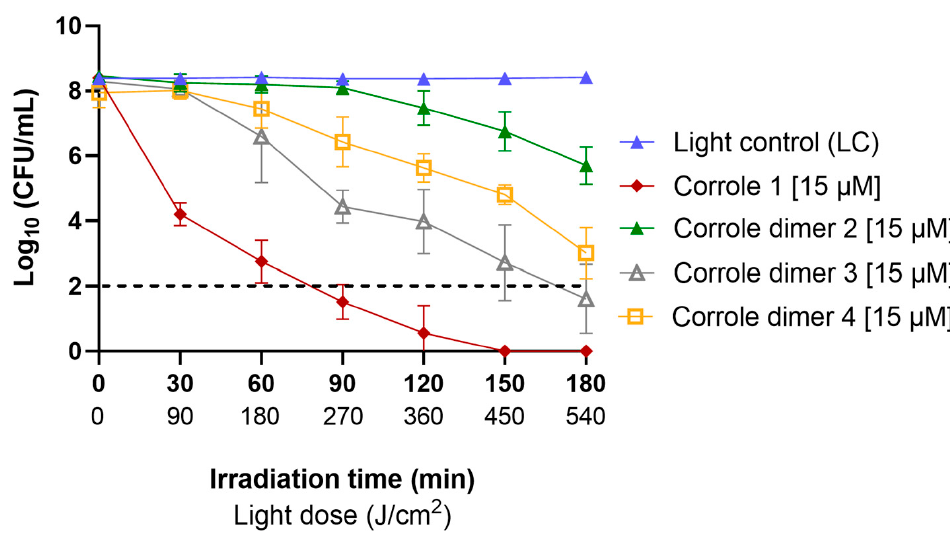
Figure 3. aPDT inactivation of S. aureus cells, in the presence of corrole precursor 1 and corrole dimers 2 , 3 , and 4 , at 15 µ M for a total of 180 min (samples collected and quantified at 30 min intervals) of irradiation with white light (50 mW/cm 2 ). On the X-axis, light dose is also presented (J/cm 2 ) along with irradiation time (min). Light control (LC) corresponds to the exposure of bacterial cells to white light, with no PS added; Dark control (DC) corresponding to the exposure of bacterial cells to PS at 15 µ M in the absence of light is not shown on the graph; however, no alterations was observed during the incubation time. Sample data values are expressed as the mean of three independent experiments with two replicates; light control data values are expressed as the mean of all the independent assays for all the tested compounds (individual values for light and dark controls are presented in Supplementary Materials, Figure S3); error bars represent the standard deviation (SD) between the experiments. In some cases, SD bars may be covered behind the experimental point symbols. The dashed line represents the detection limit of the method used.